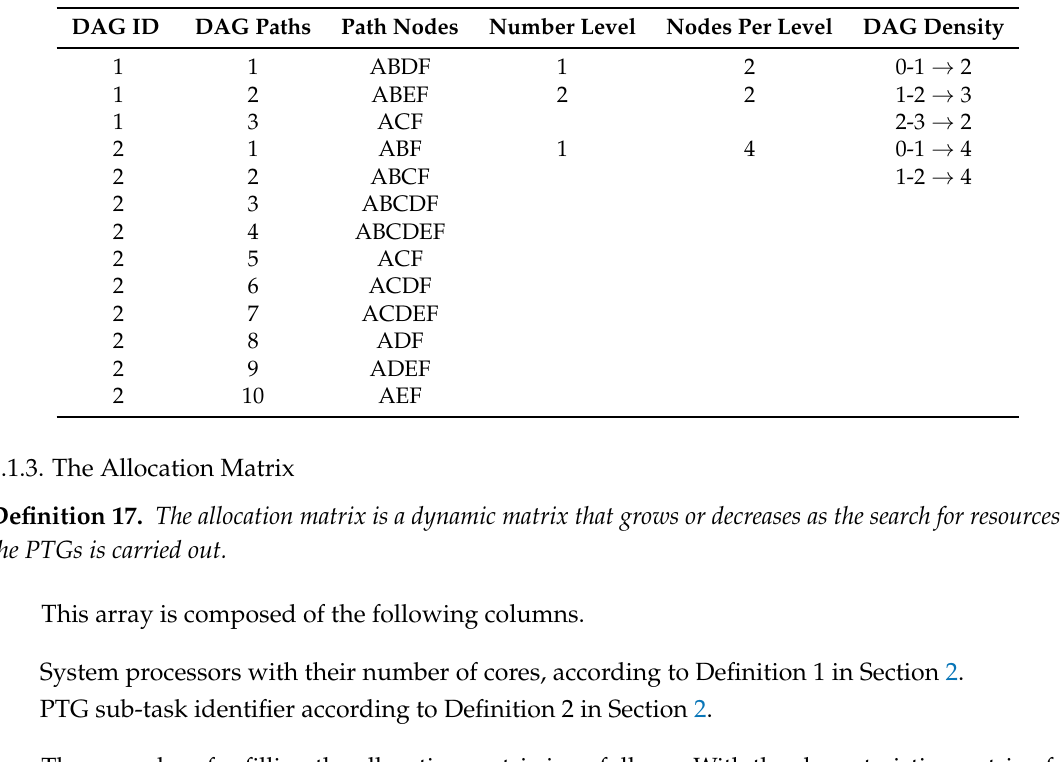
Figure 3. A second six-node DAG task. Table 2. Characteristics matrix of the Parallel Task Graphs (PTGs) from Figures 2 and